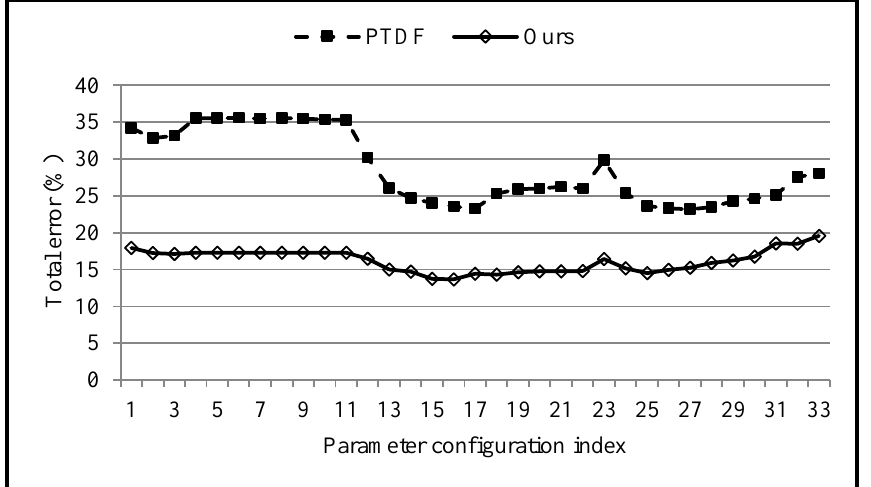
Figure 22. Cloth simulation time and total error at different CR values.